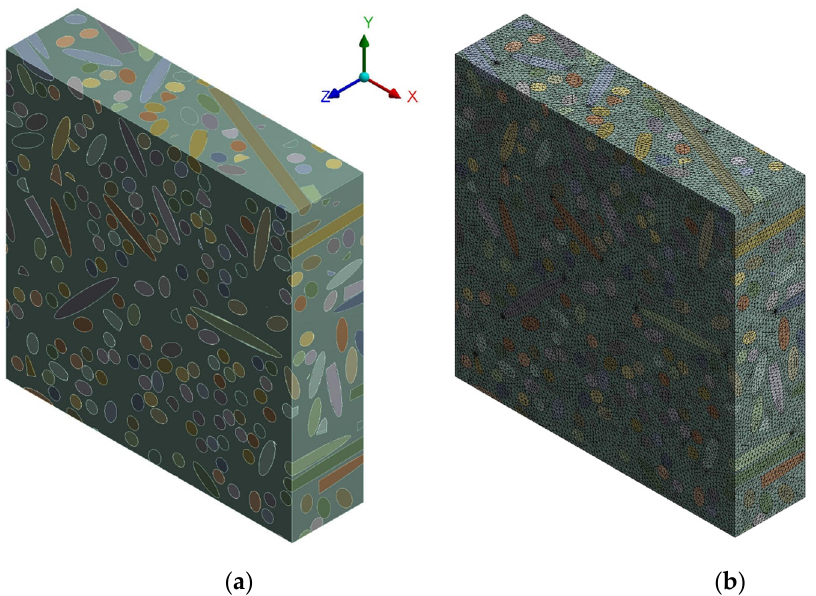
Figure 3. RVE of an epoxy short sisal fiber biocomposite having Vf = 0.35: ( a ) 3D view, ( b ) 3D view of the mesh.